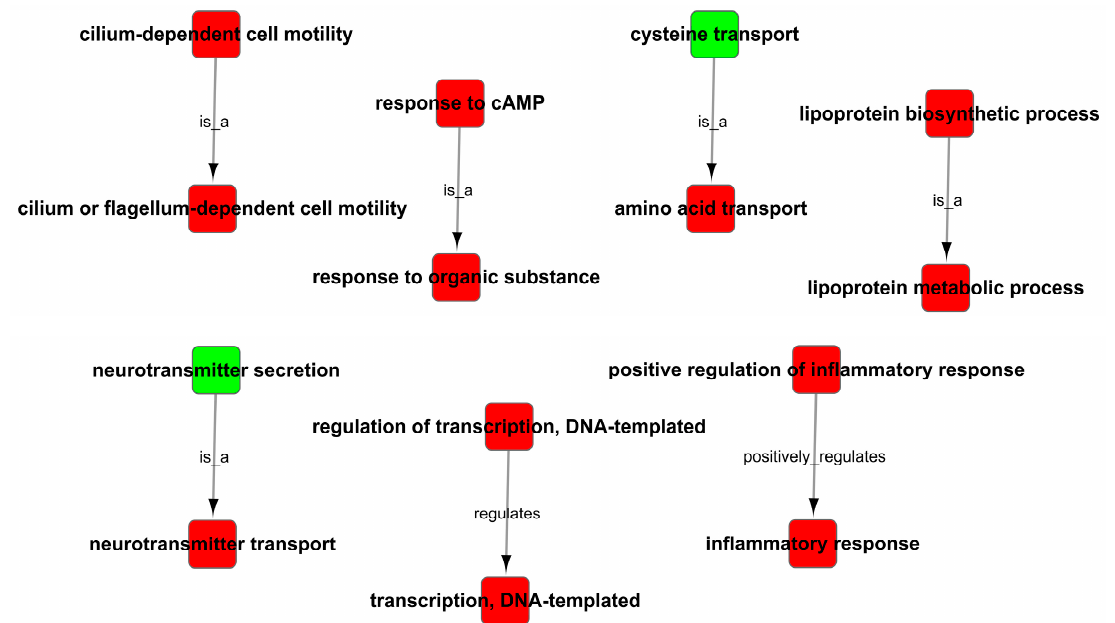
Figure 9. GO trees analysis of enrichment of GO